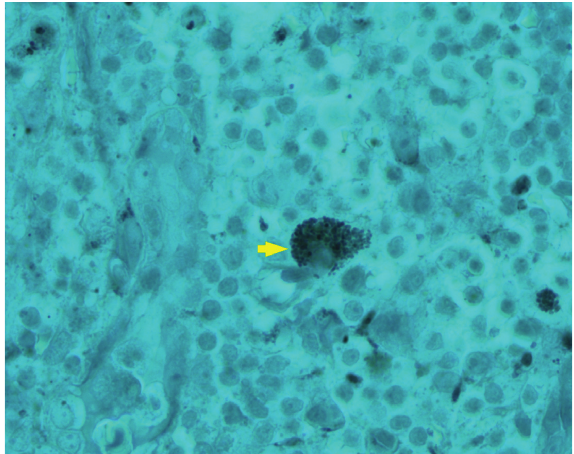
Figure 2: Toxoplasma gondii bradyzoite as demonstrated by GMS stain (x100